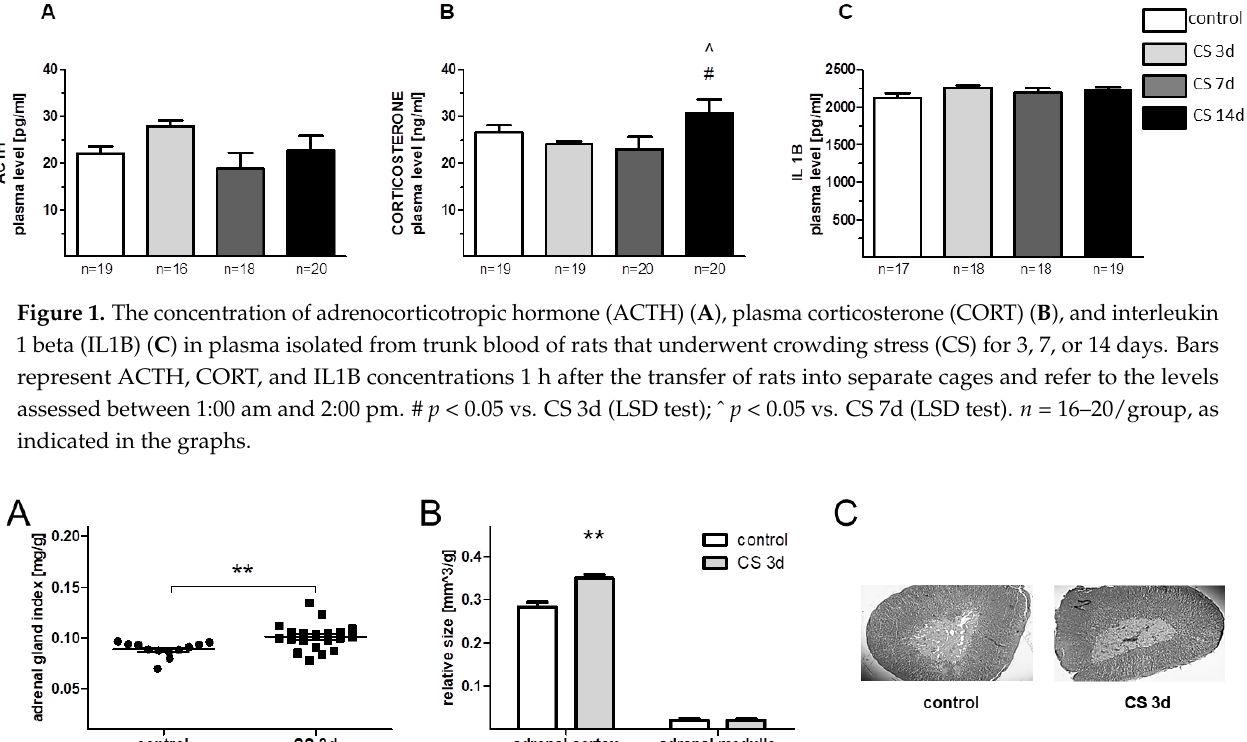
Figure 2. Three-day crowding stress affected adrenal gland morphometry. ( A ) stress effect on the adrenal gland index measured as the ratio of adrenal mass to body weight ( n = 10); ( B ) stress-evoked increase of the adrenal cortex volume (control: n = 3; CS 3d: n = 4); ( C ) representative sections of the adrenal gland from control and stressed rats stained with hematoxylin and eosin. ** p < 0.01 (unpaired t -test).